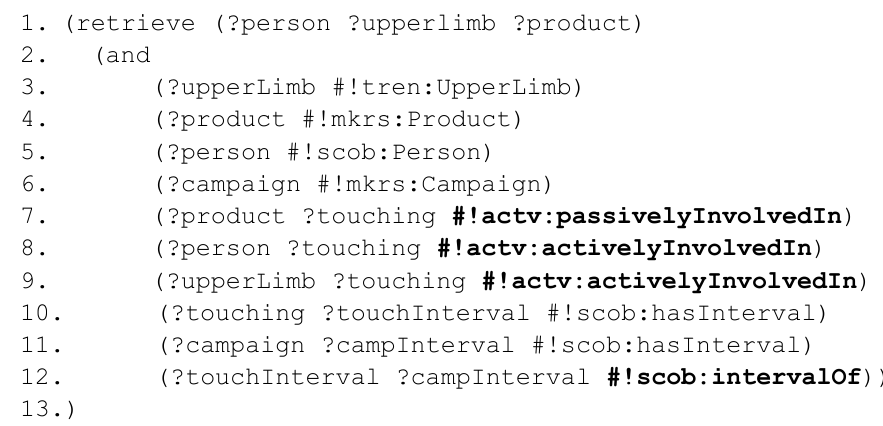
Figure 14. Query for different interactions during a campaign.